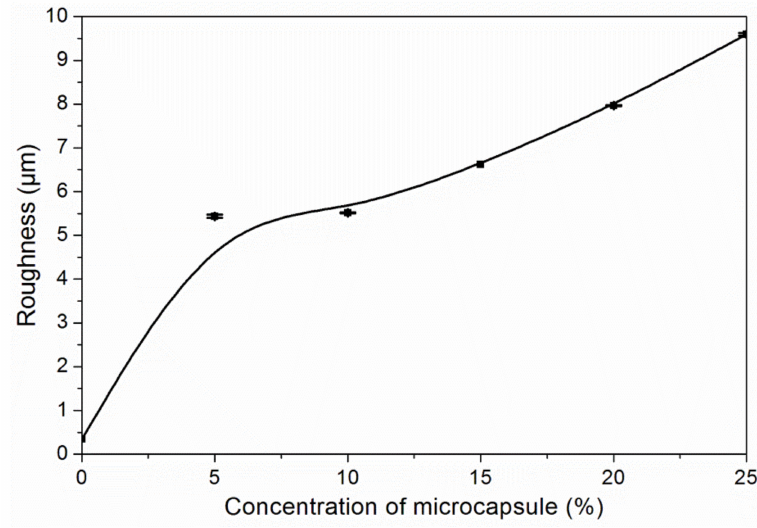
Figure 6. E ff ect of di ff erent concentration of microcapsules on the roughness of waterborne coatings.